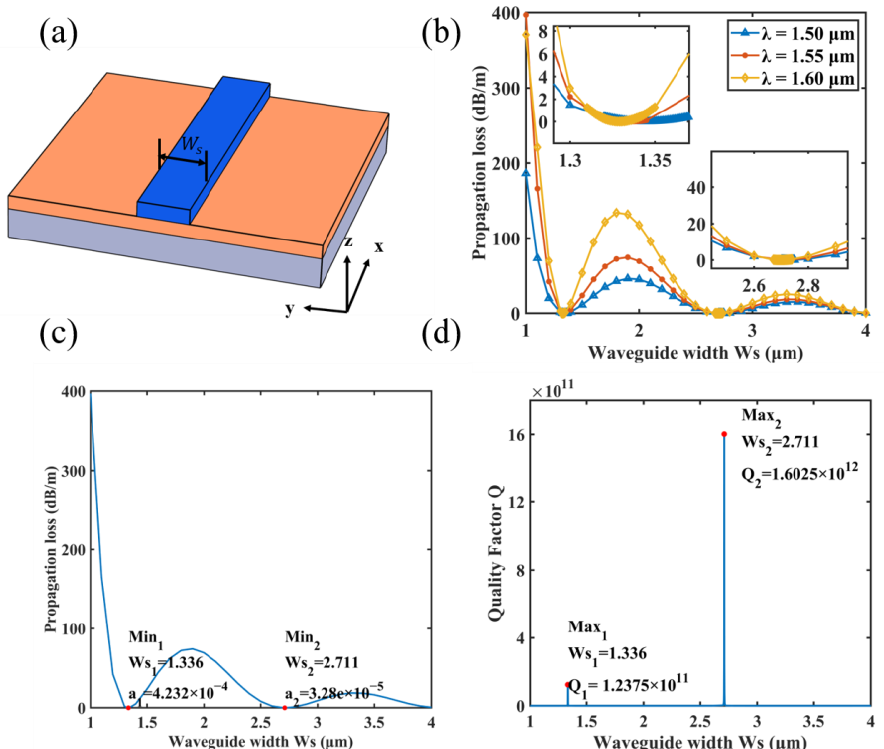
Figure 6. Simulation of the optical properties of the BIC structure under the straight waveguide: ( a ) illustration of the straight waveguide structure supporting a BIC mode, where Ws denotes the width of the straight waveguide; ( b ) the variation curve of propagation loss with waveguide width Ws at different wavelengths in the straight waveguide shown in ( a ) is simulatedl ( c ) the propagation loss curve of the straight waveguide at 1.55 µ m wavelength as a function of waveguide width Ws ; ( d ) the quality factor of the straight waveguide as a function of waveguide width Ws at the wavelength of 1.55 µ